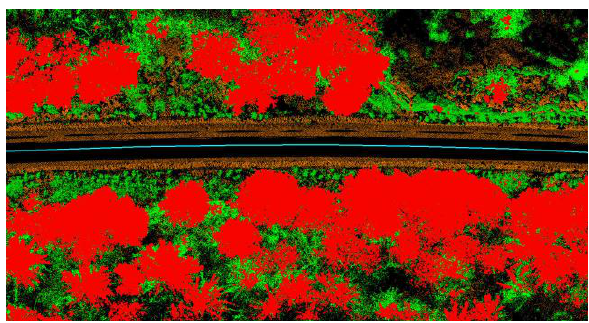
Figure 20: Checking the tree-fall hazard around a rail track in Sweden using TerraScan (top view)